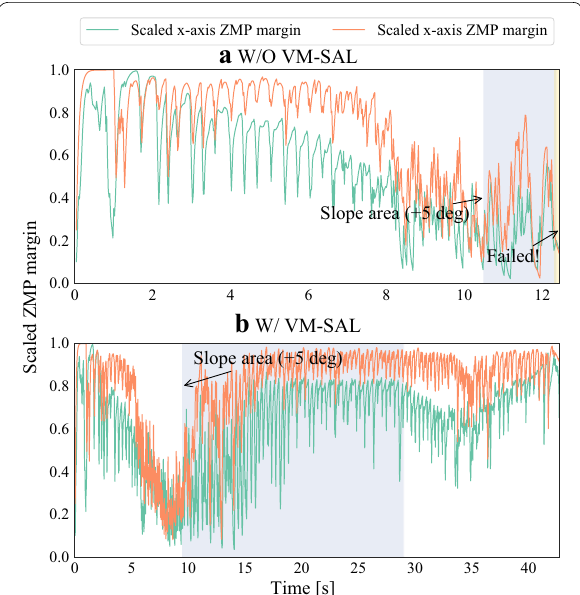
Fig. 13 ZMP margin scaled by the maximum distance to the edge of the support polygons In both cases, ZMP could be kept in the support polygons, although its margin was small when the robot ran; a in the case without VM-SAL, the robot could not keep its balance on the slope and failed; b in the case with VM-SAL, even on the slope, the robot got steady walking and ZMP also became stable